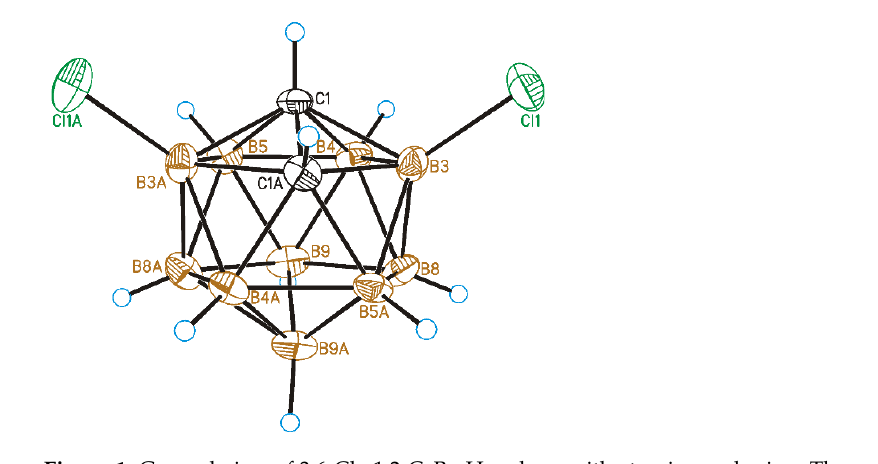
Figure 1. General view of 3,6-Cl 2 -1,2-C 2 B 10 H 10 along with atomic numbering. Thermal ellipsoids are shown at 50% probability level.